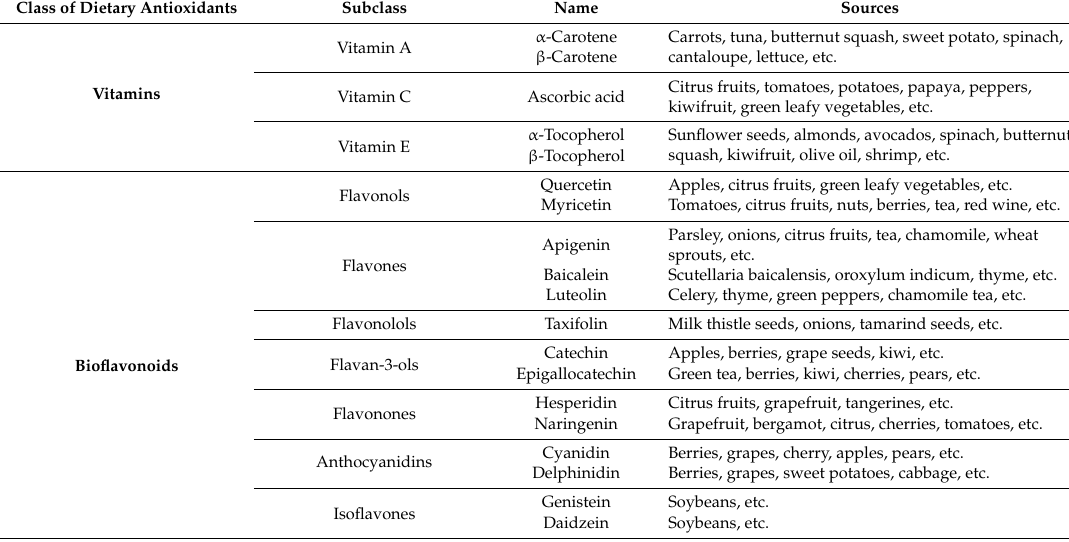
Table 2. A list of representative dietary antioxidants and their canonical